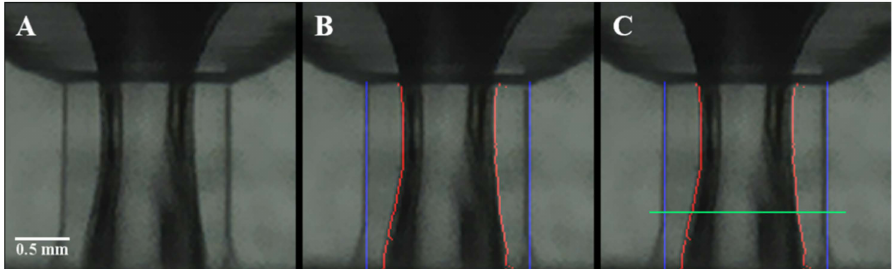
Figure 2. Sample image of flow conditions inside the exit orifice of the atomizer ( µ = 0.39 Pa · s; Q L = 40 L · h − 1 , p gas = 0.4 MPa, air-to-liquid ratio (ALR) = 0.05). ( A ) Image before analysis. ( B ) Image with marked boundaries of the exit orifice (blue lines), as well as boundaries between liquid and gas core (red). ( C ) Image with additional line probe (green line).